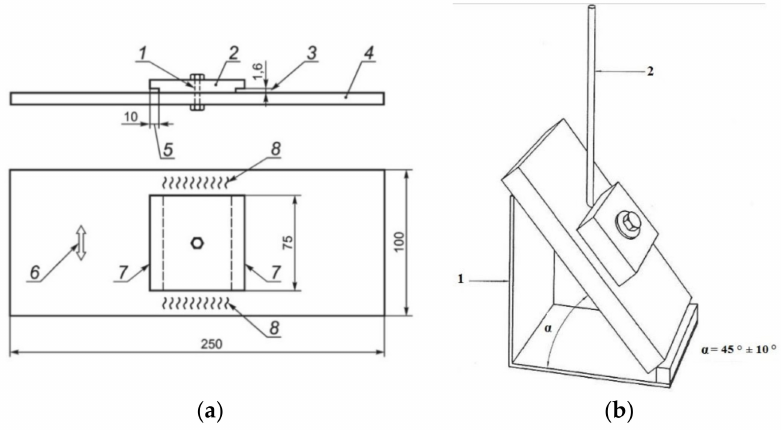
Figure 1. Control thermal severity (CTS) specimen: ( a ) scheme of CTS test; 1 –hole 13 mm diameter, 2—top plate, 3—root notch gap, 4—bottom plate, 5—root notch depth, 6 –rolling direction,